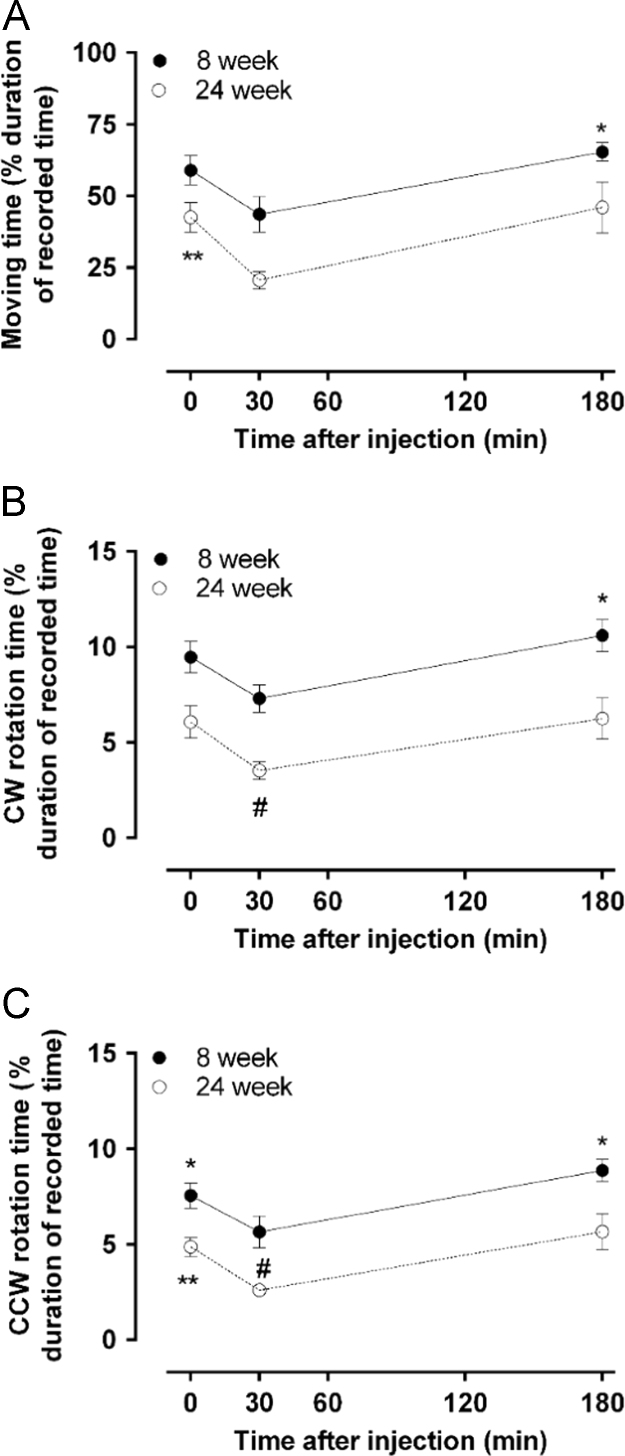
Detailed analysis of low-dose morphine-induced behavioral changes. Three distinct animal behavior (A. Moving time, B. Clockwise (CW) rotation time, C. Counter-clockwise (CCW) rotation time) were recorded after a single-dose of morphine (5 mg/kg, s.c.) in 8 and 24 week old rats and analyzed using ActiMot software (TSE Systems). Measurements were taken prior to drug administration (basal), 30 and 180 min post-administration, as described in Section 2. Differences between the 30 min time point and the basal or 180 min time points were significantly different (*p<0.05, ***p<0.001 and ****p<0.0001, using repeated measure one-way ANOVA with Sidak's multiple comparison post hoc test). Likewise, significant differences against 8 week old animals were observed for some time points (##p<0.01 and ###p<0.001, using non-repeated measure one-way ANOVA with Sidak's multiple comparison post hoc test). All data are presented as mean±SEM, n=5 per group.